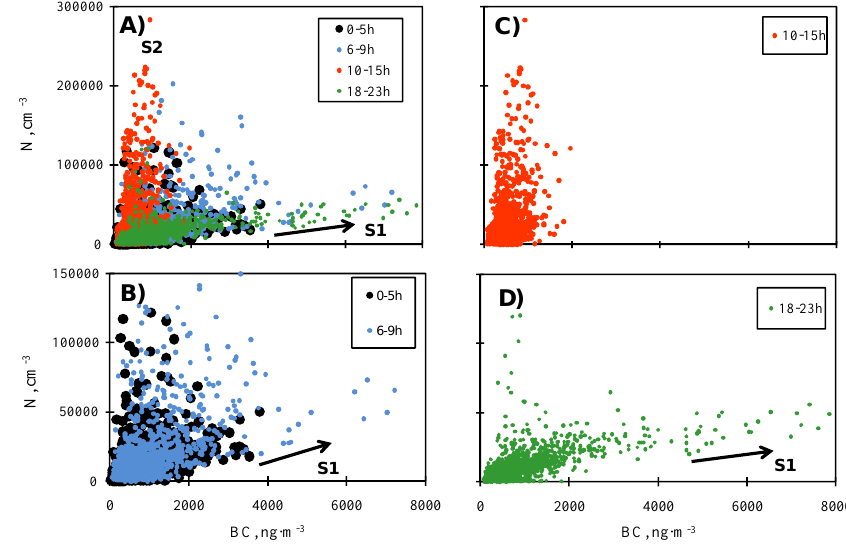
Fig. 5. Hourly average values of the particle number N versus BC particle concentrations at different times of the day in Huelva city. S1 and S2 indicate the lines of minimum and maximum slopes which contain the N-vs.-BC data.